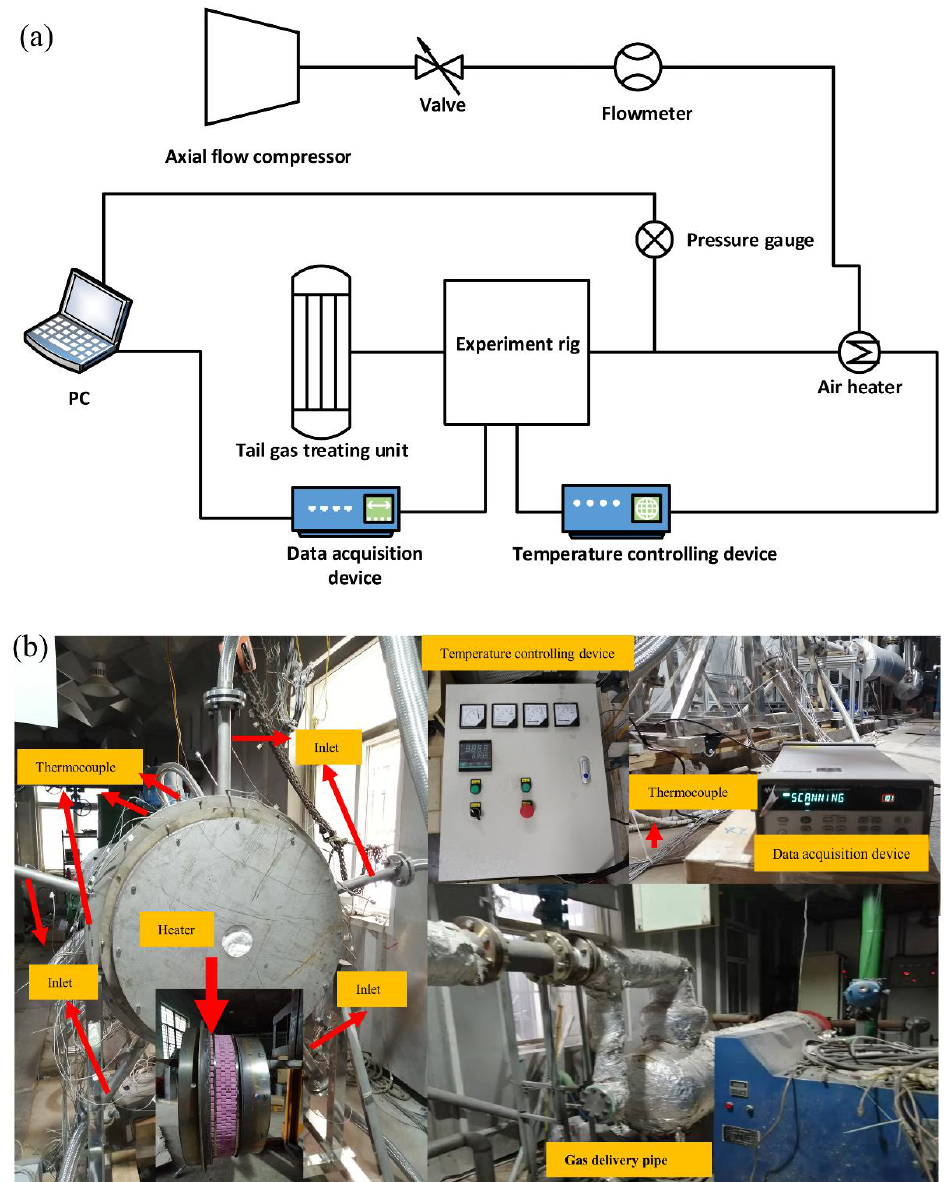
Figure 2. ( a ) Schematic of the experimental system; ( b ) Photograph of main experimental parts.